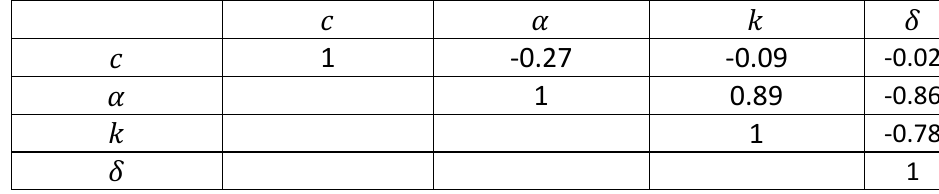
Table 3. The correlation among the estimated model